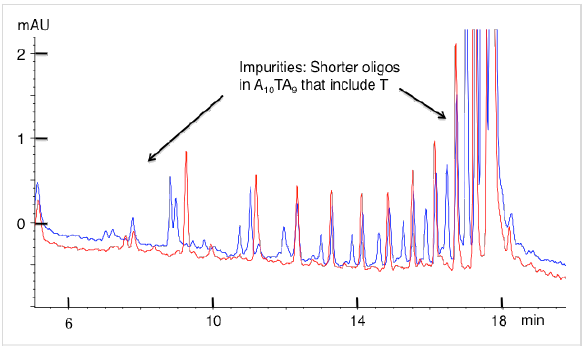
is replaced by two peaks (blue trace) with an approximate 2:1 ratio upon osmylation. Figure 7 (magnification of Figure 6) illustrates that the first major impurity (red) is also replaced by two peaks (blue) and this pattern continues up to about n = 11; namely, every impurity peak that includes a T reacts with OsBp and forms two isomeric products in an approximate 2:1